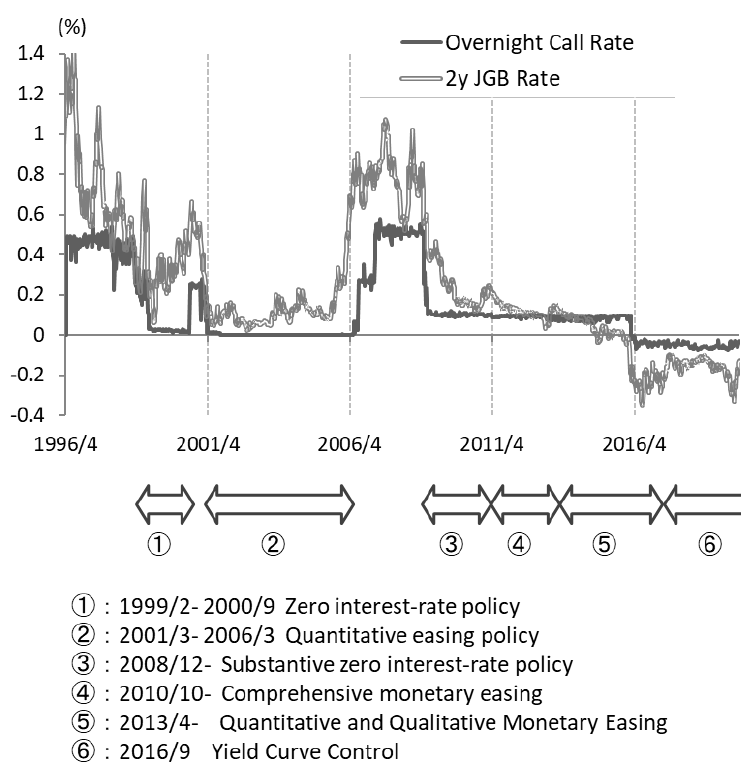
Figure 14. Monetary policy change with the medium- and short-term interest rates.